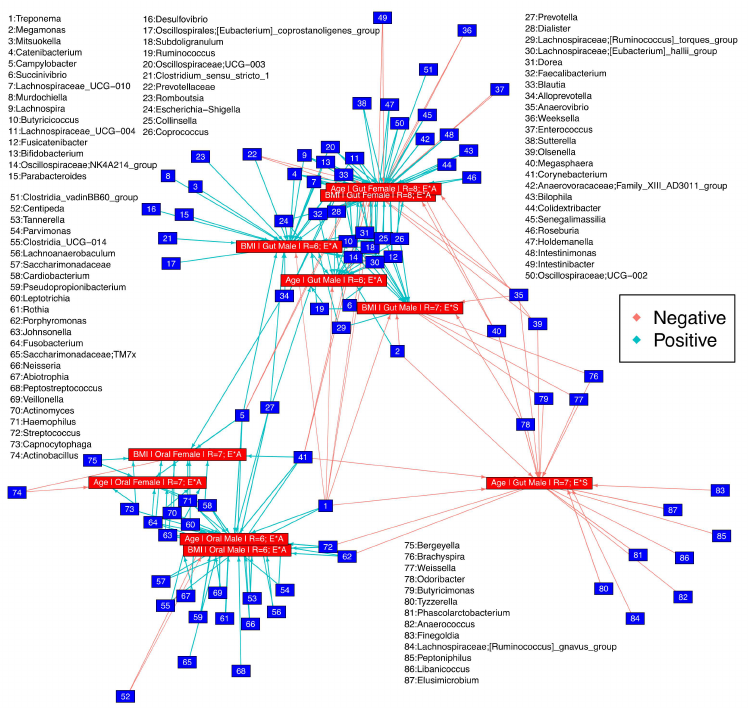
Figure 5. Relationships recovered after applying Hurlbert’s B N to two environmental properties, age and BMI on different sets of environments as a combination of ethnicity and antibiotics usage status (E*A) or ethnicity and smoking status (E*S) with R representing the possible sets of environments. Genera tagged as “Positive” increase in abundance, whilst those tagged as “Negative” decrease in abundance in relationship to the environmental property considered as well as the target set of environments. Further details are given in Supplementary Figure